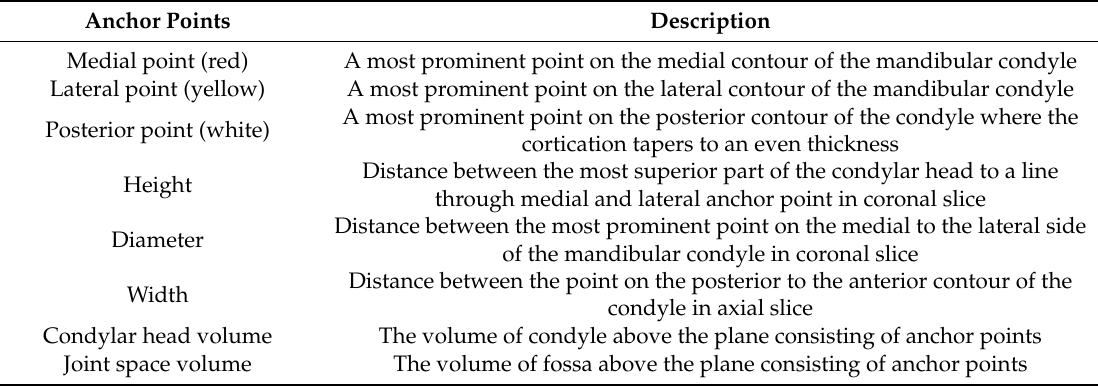
Table 1. Definition of condylar morphologic landmarks and